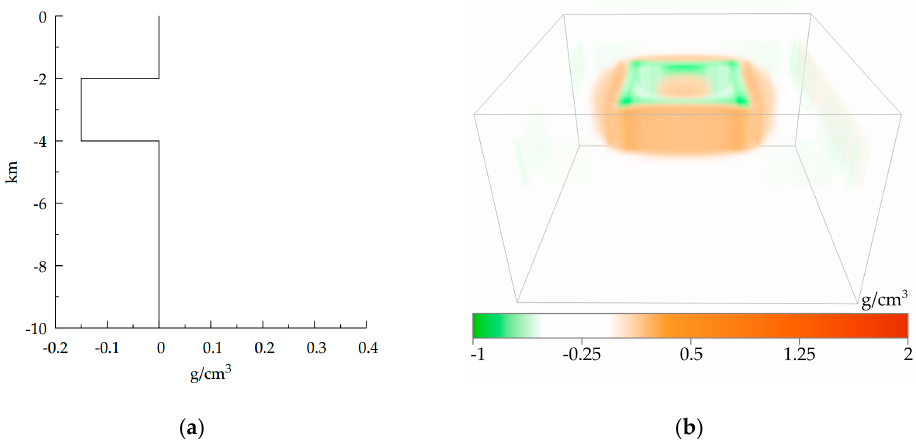
Figure 6. Synthetic example modification #1: ( a ) Background density distribution ρ 0 ( z ) and ( b ) Linear problem inverse solution, which is based on it.